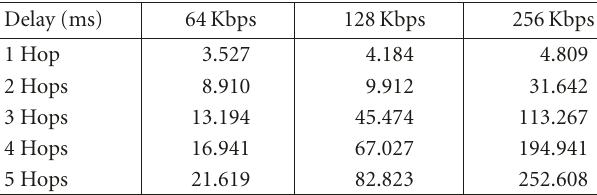
Table 5: Delay: unicast routing and autoconfiguration.